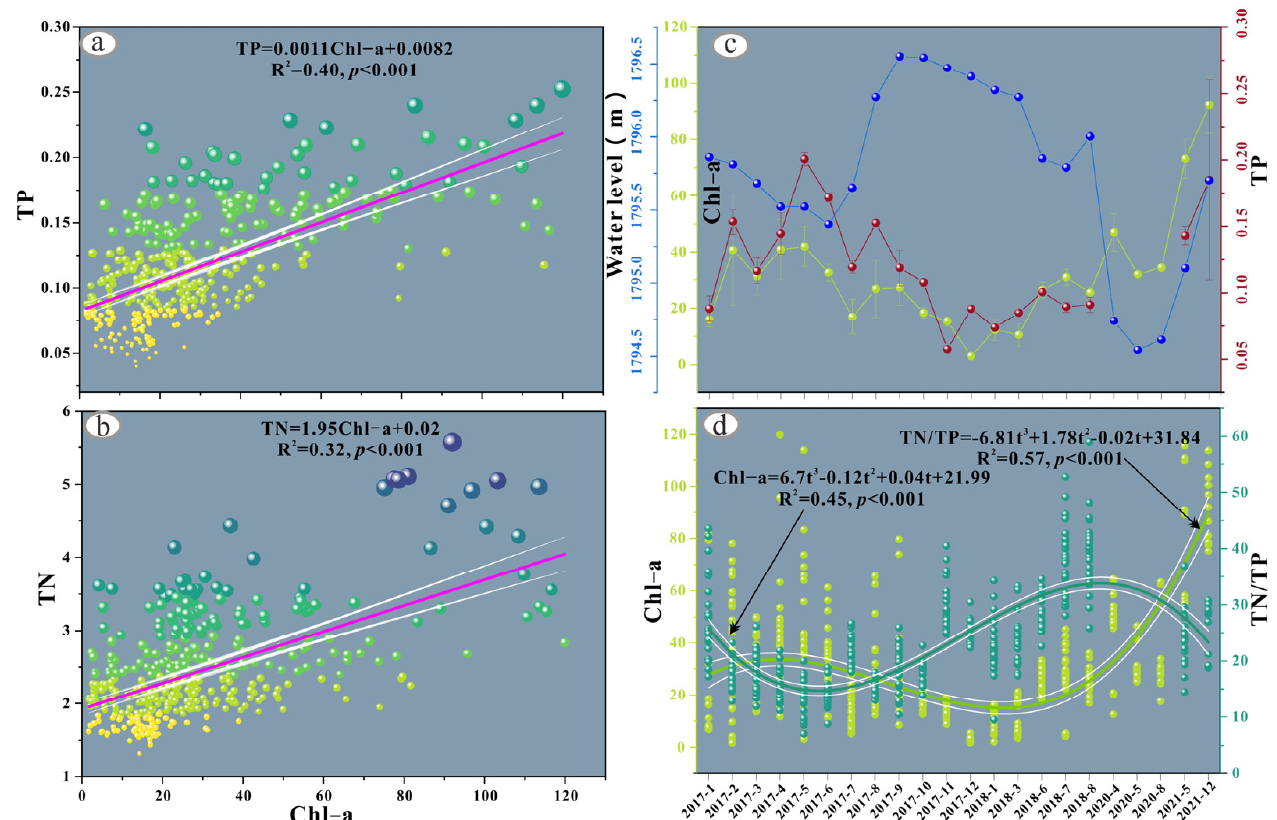
Figure 9. The effects of nutrients on HABs. ( a ) Linear regression between TP and Chl-a; ( b ) changes in water level, TP, and Chl-a during the monitoring time; ( c ) linear regression between TN and Chl-a; and ( d ) Chl-a concentrations increased with the decreasing of TN/TP ratios.